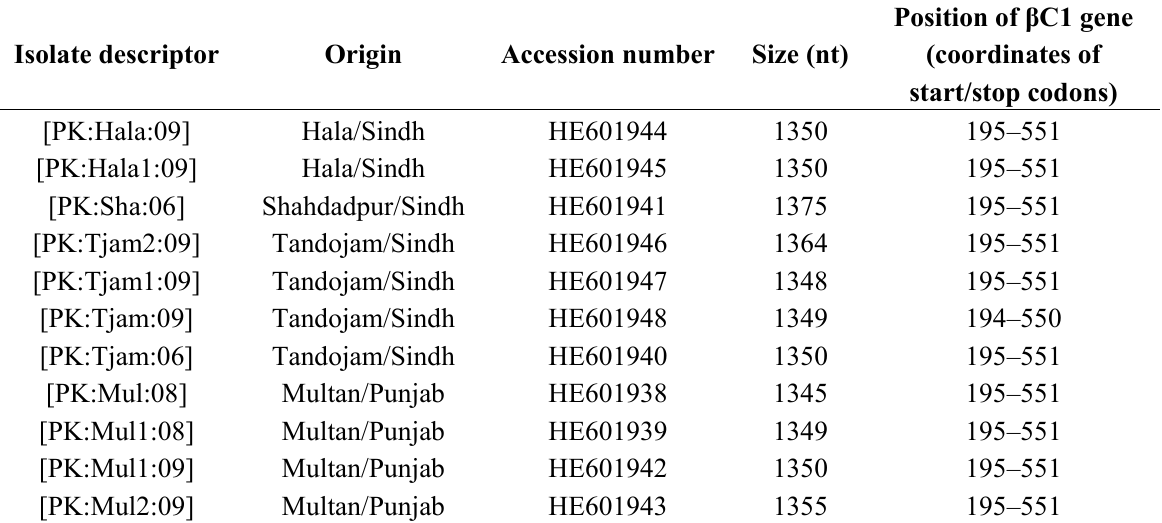
Table 1. Origins and features of full-length